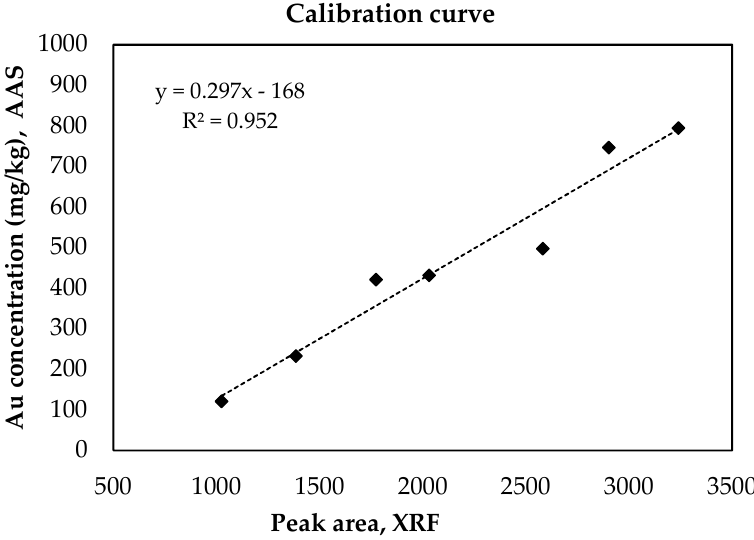
Figure 1. Calibration curve for FPXRF obtained by using real samples of PCBS as standards (number of standards: 7).